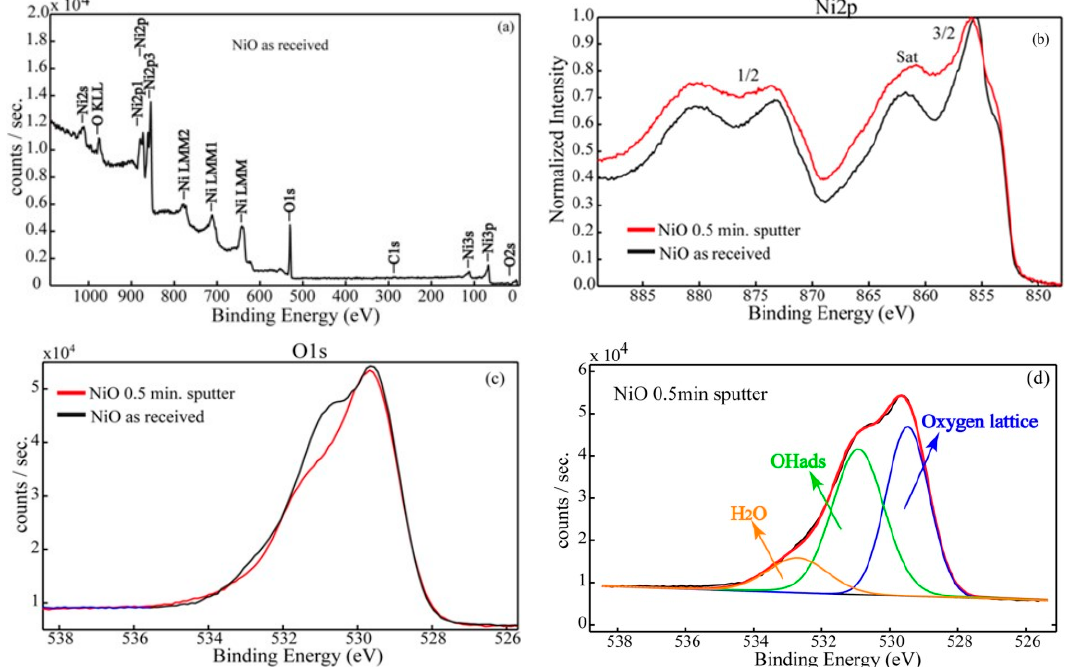
Figure 3. Survey spectrum in the “as-received” stage ( a ); the superimposed high-resolution spectra for Ni2p ( b ) and O1s ( c ) in the “as-received” stage and after a gentle Ar ion etch, as well as the O1s deconvoluted spectrum in the “as-received” stage ( d ).